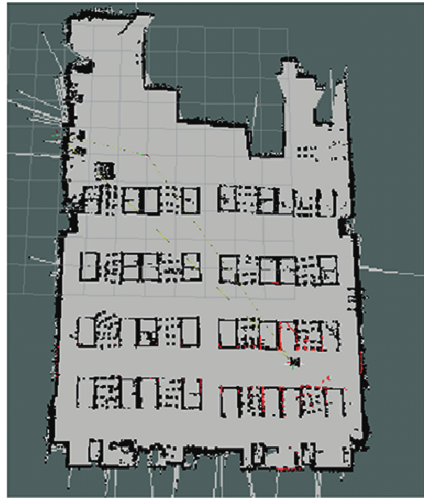
Figure 12: Hector-SLAM map for lab